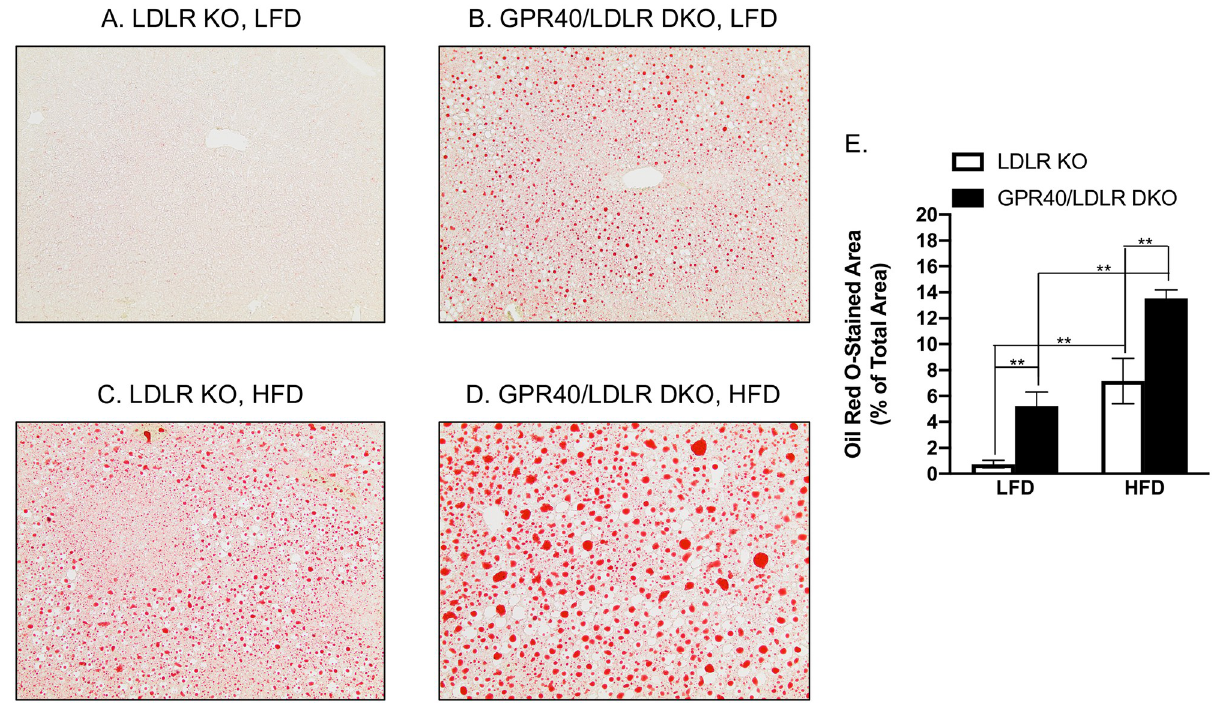
Fig 3. The effect of GPR40 KO on steatosis in LFD- or HFD-fed LDLR-deficient mice. A–D: Representative images of liver sections with Oil Red O staining (magnification: x100). E: The positively stained areas of Oil Red O staining in tissue sections were quantified and compared among all groups. The data are presented as means ± SE (n = 6–8). One-way ANOVA and Student’s t test were used for the statistical analysis. �� p < 0.01. LFD, low-fat diet; HFD, high-fat diet; KO, knockout; DKO, double knockout.